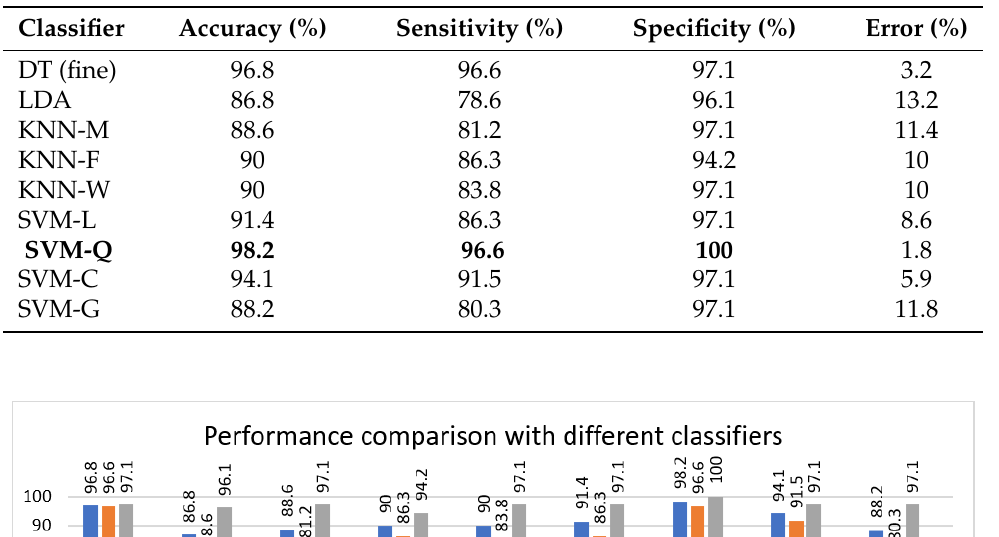
Table 4. Performance of feature set F4 with a range of classification methods.